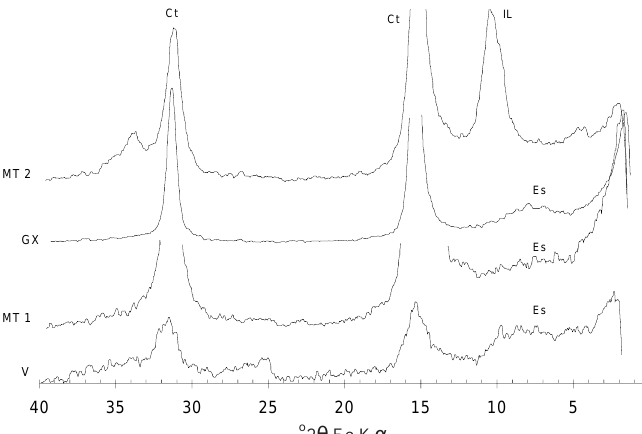
Figura 7. Difratogramas de Raios-X da fração argila desferrificada dos solos com horizonte Bt Ta e horizonte C estudados (lâminas de argila orientada). Ct – Caulinita; Es – Esmectita; IL-